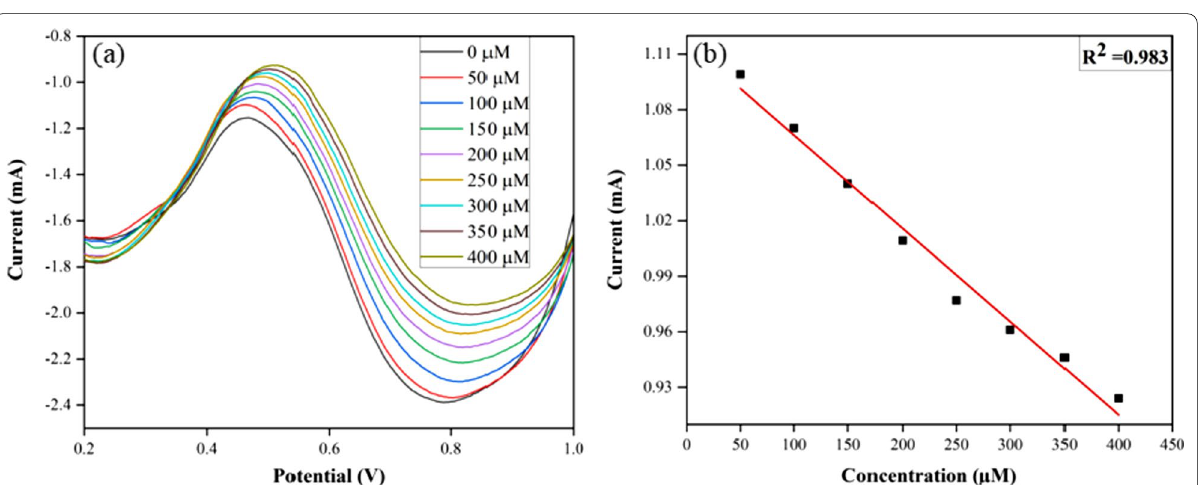
Fig. 6 a DPV of cotton/ppy/Cu/Cu–Mn modified electrode for glucose (0–400 µM) from 0.2 V to 1.0 V, and b calibration plot between glucose concentration and